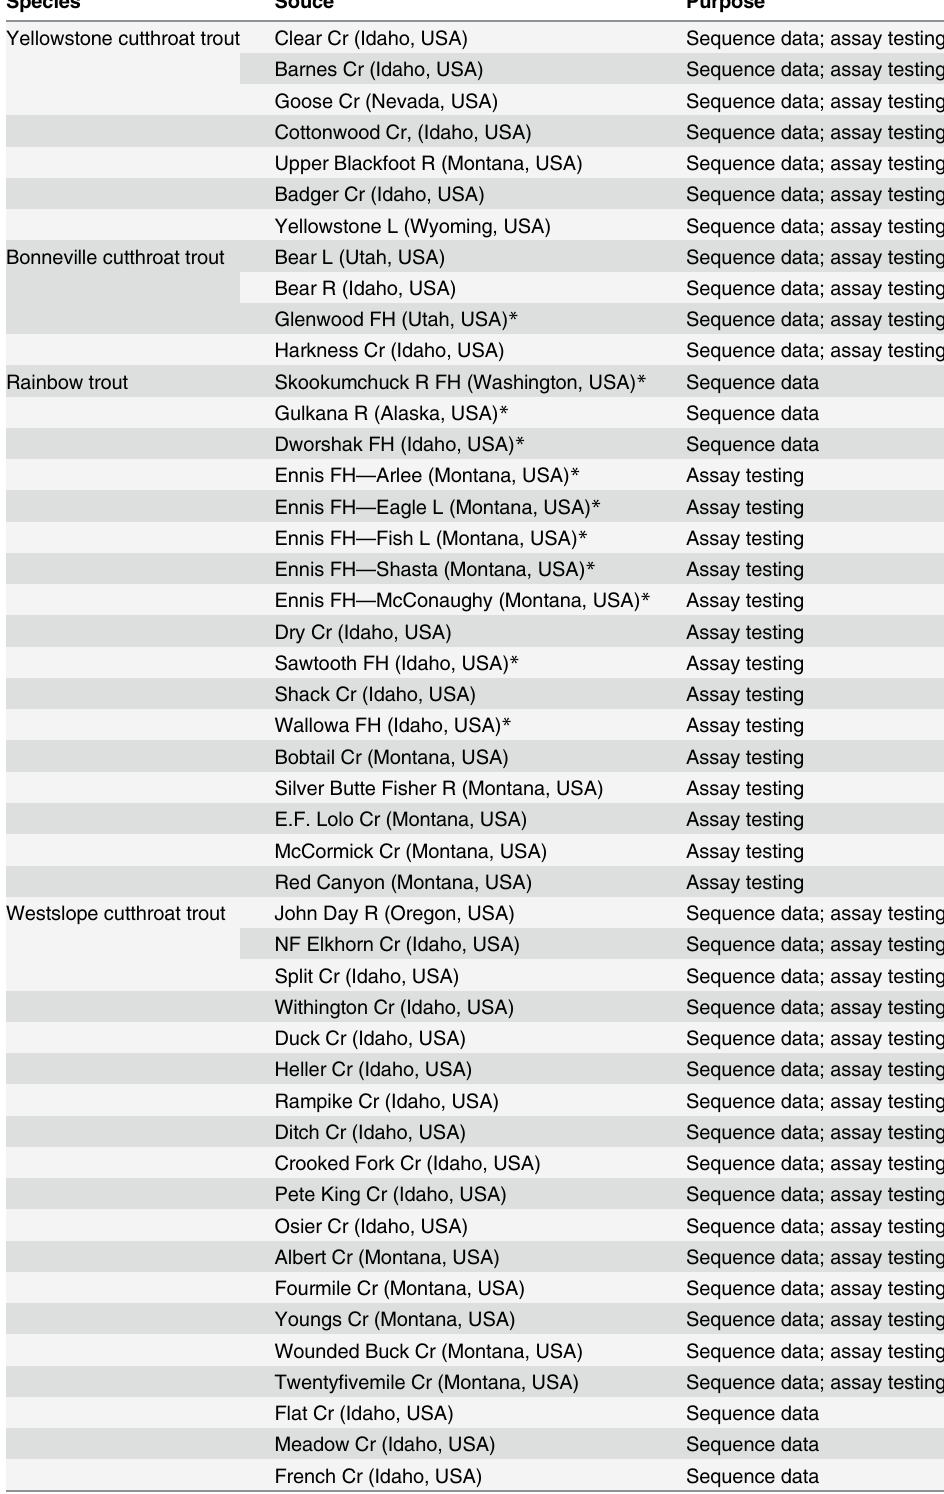
Table 1. Source populations for fish used in assay design and